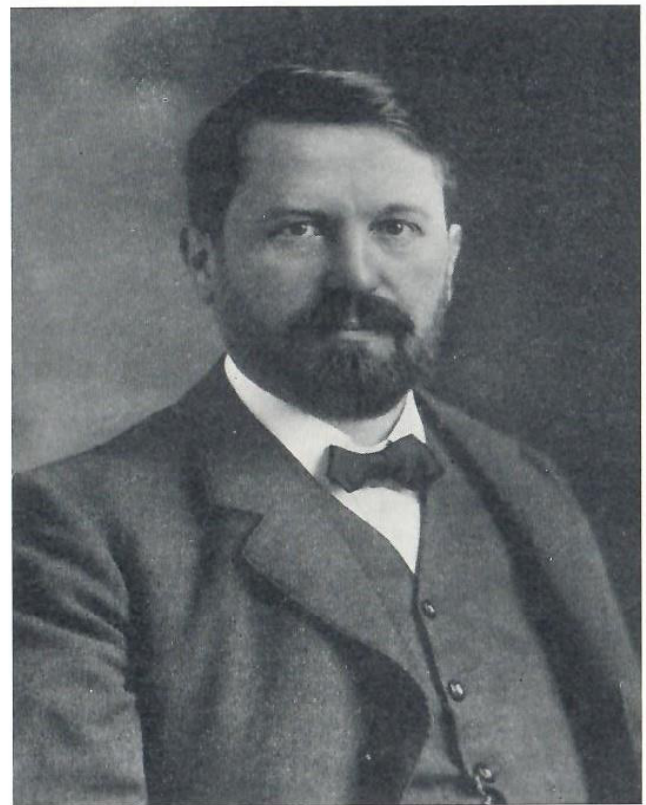
Figure 1. Theodor Boveri, the biologist and ‘father’ of centrosome research. Boveri was born in 1862 in Bamberg, Germany. After studying Anatomy and Biology he became one of the leading scientists of cell biology of his time. Reproduced from [3].